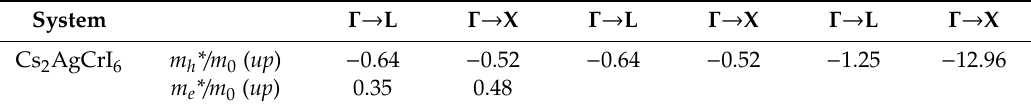
Table 6. E ff ective masses of conducting electrons and holes for Cs 2 AgCrI 6 a